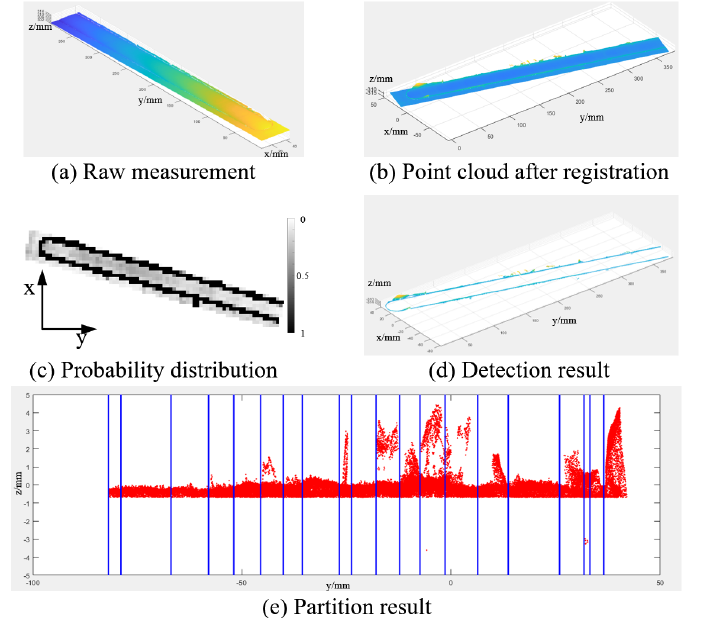
Figure 12. Weld seam feature extraction result.